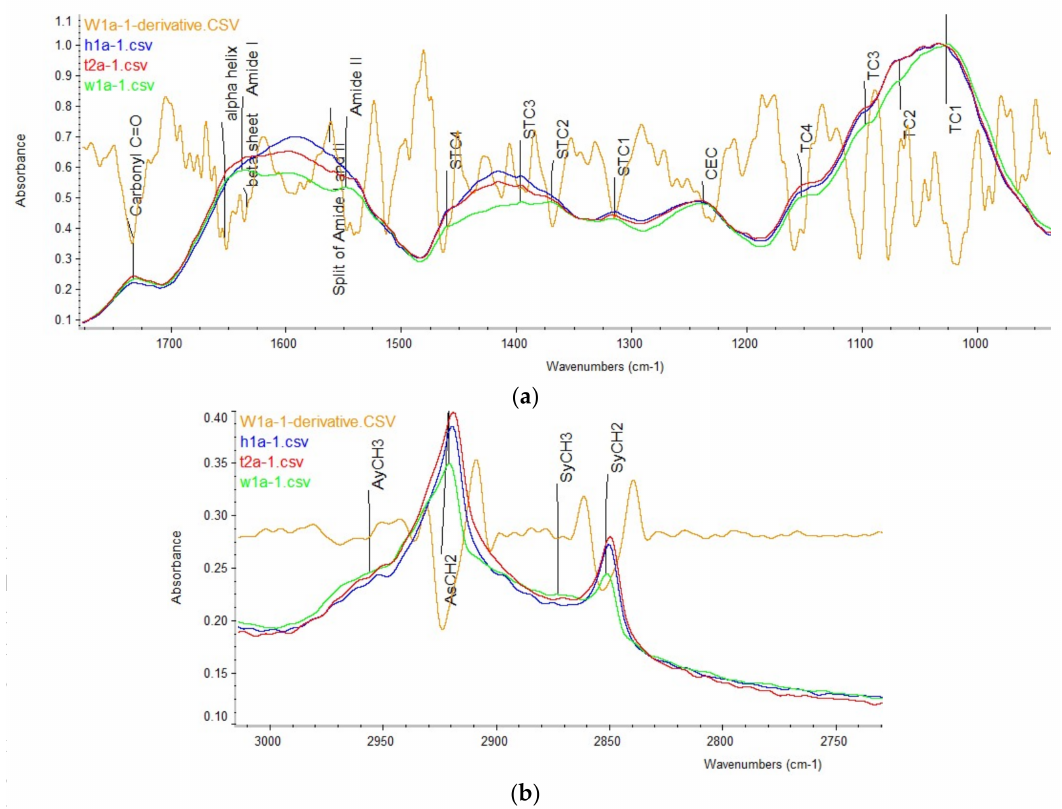
Figure 5. Spectra of transgenic (H1–H3, H5–H10, H12, H14; T2–T3, T5–T7) and WT (W1–W4) control with annotations. ( a ) Carbonyl C=O (CCO), Amide and carbohydrate (CHO) region; ( b ) Symmetric and asymmetric CH2 and CH3 (ASCC) region. TC1-4 and STC1-4 are four peaks in total carbohydrate (TC) and structural carbohydrate (STC) regions, respectively; CEC, cellulosic compounds region; SyCH2, symmetric CH2; SyCH3, symmetric CH3; AsCH2, asymmetric CH2; AsCH3, asymmetric CH3. W1a-1.csv, t2a-1.csv, h1a-1.csv are spectral examples of WT, TT8i and HB12i alfalfa. W1a-1-derivative.csv is the second derivative of w1a spectrum, showing as an